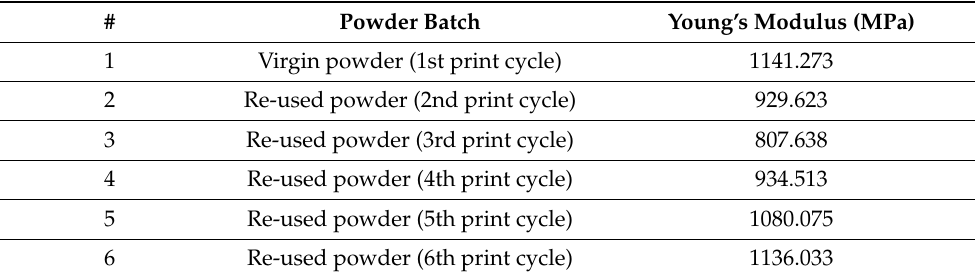
Table 11. Young’s modulus of printed parts after 100%